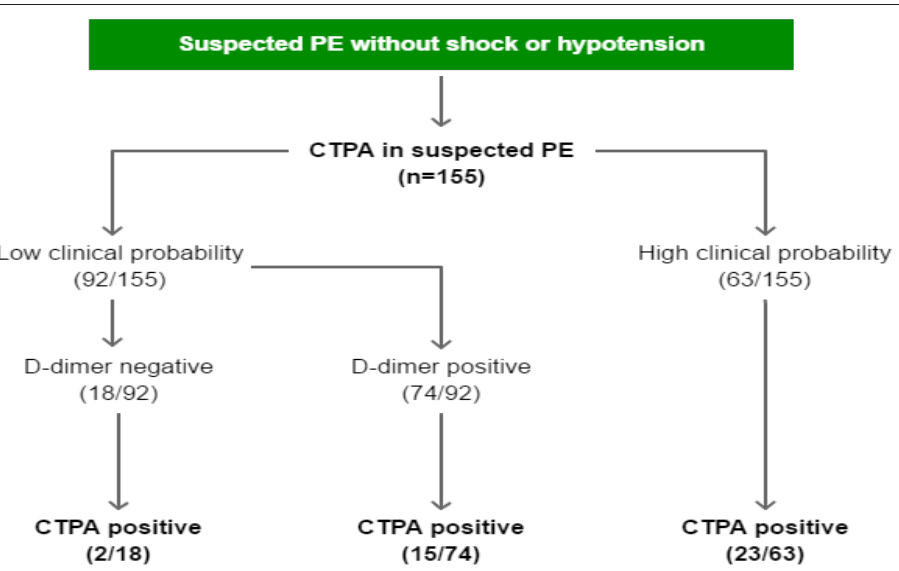
CTPA, computed tomography pulmonary angiography; sGS, simplified Geneva Score.